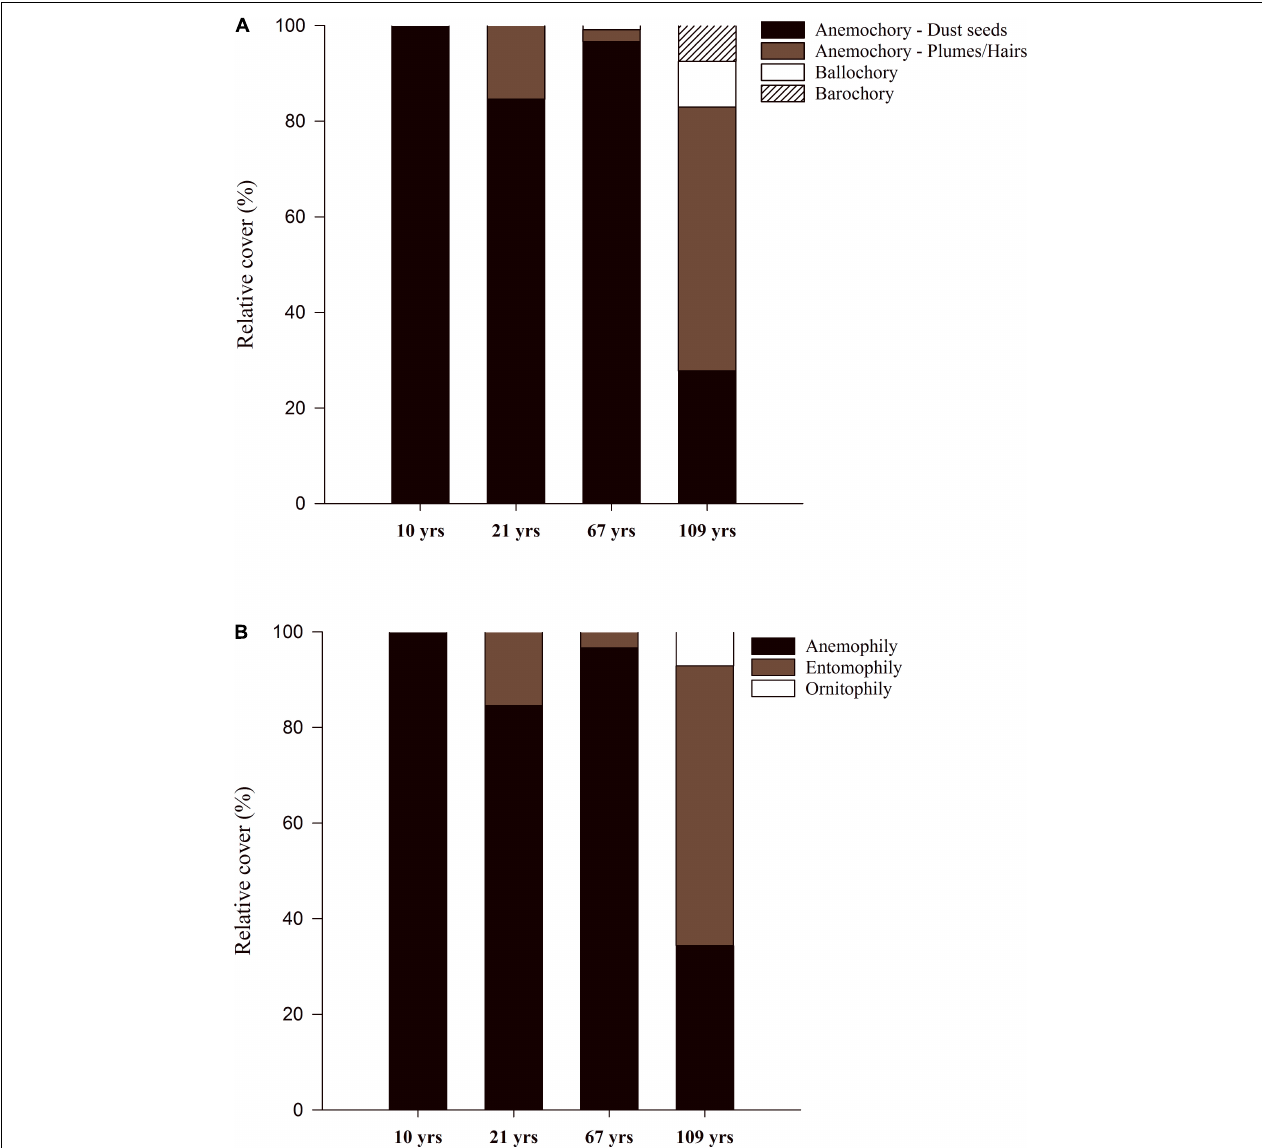
FIGURE 5 | Average relative cover (%) of vascular plant species with different dispersal (A) and pollination (B) syndromes in four study sites (S1-S4) along a post-glacial chronosequence (10–109 years of succession) at Humboldt Peak, Venezuela.